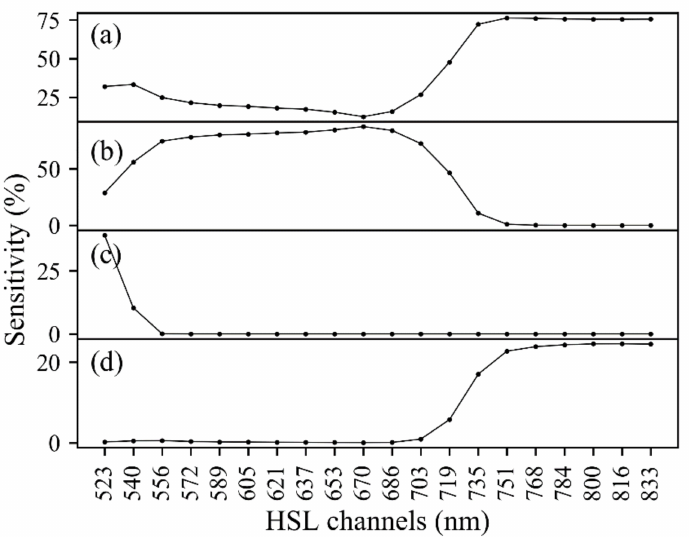
Figure 5. Sensitivity analysis of the ( a ) plant structure parameter ( N ), ( b ) total amount of chlorophyll a and chlorophyll b (Cab), ( c ) carotenoid (Car), and ( d ) leaf mass per area (LMA) in terms of the re- flectance of HSL wavelength bands. The dataset was obtained by simulating the PROSPECT-5 model.